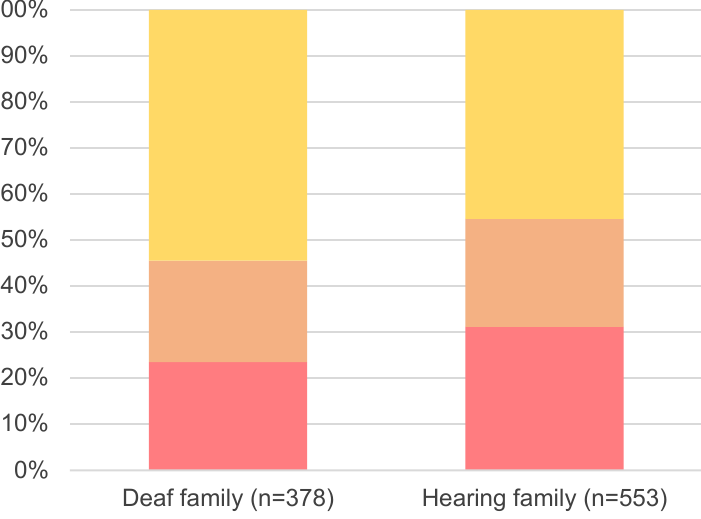
Figure 18: Distribution of fingerspelling-related tokens by nativisation category (N only) and by family language background